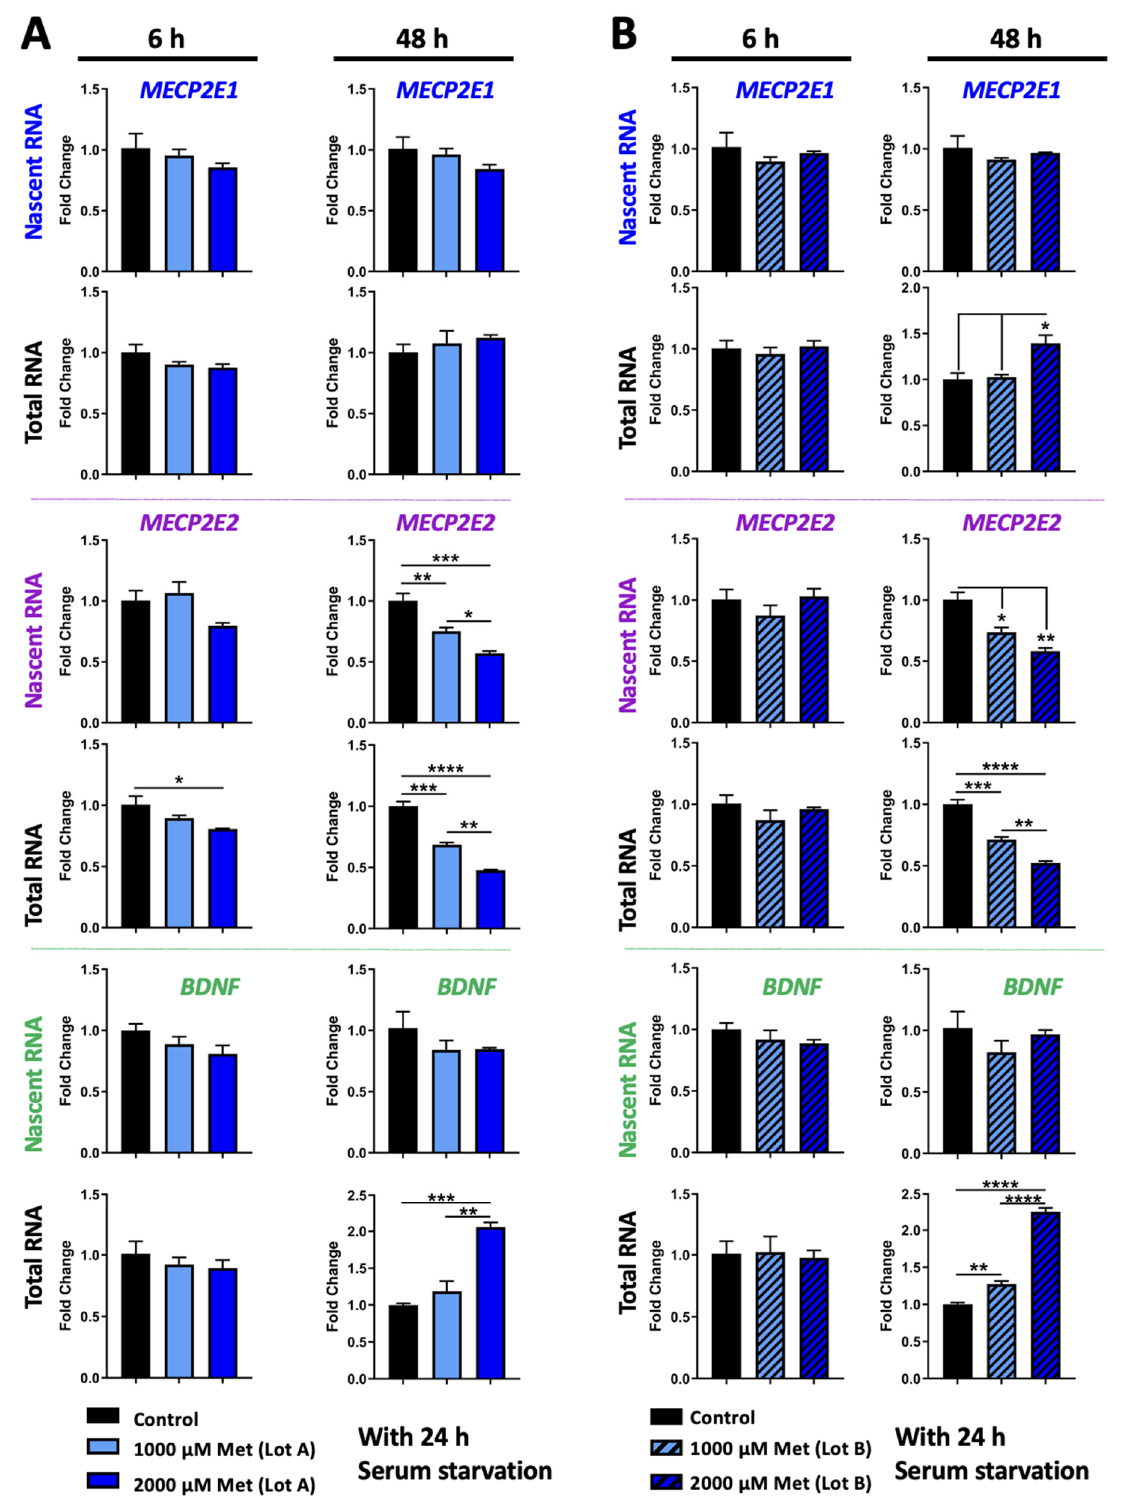
Figure 3. Transcriptional effect of two lots of metformin on MECP2E1-E2 and BDNF in Daoy cells with serum starvation. ( A , B ) Daoy cells were serum-starved for 24 h prior to drug treatment with 1000 and 2000 μ M metformin (Met) with two lots of the drug from the same company. Samples were collected at 6 and 48 h and gene transcripts were analyzed by RT-PCR for MECP2E1 , MECP2E2 , and BDNF . C T values were normalized to the housekeeping gene GAPDH and fold change was determined relative to the average control. N = 3 ± SEM. Fold change values were analyzed by one-way ANOVA followed by Tukey’s multiple comparisons test, * p < 0.05, ** p < 0.01, *** p < 0.001, and **** p < 0.0001.